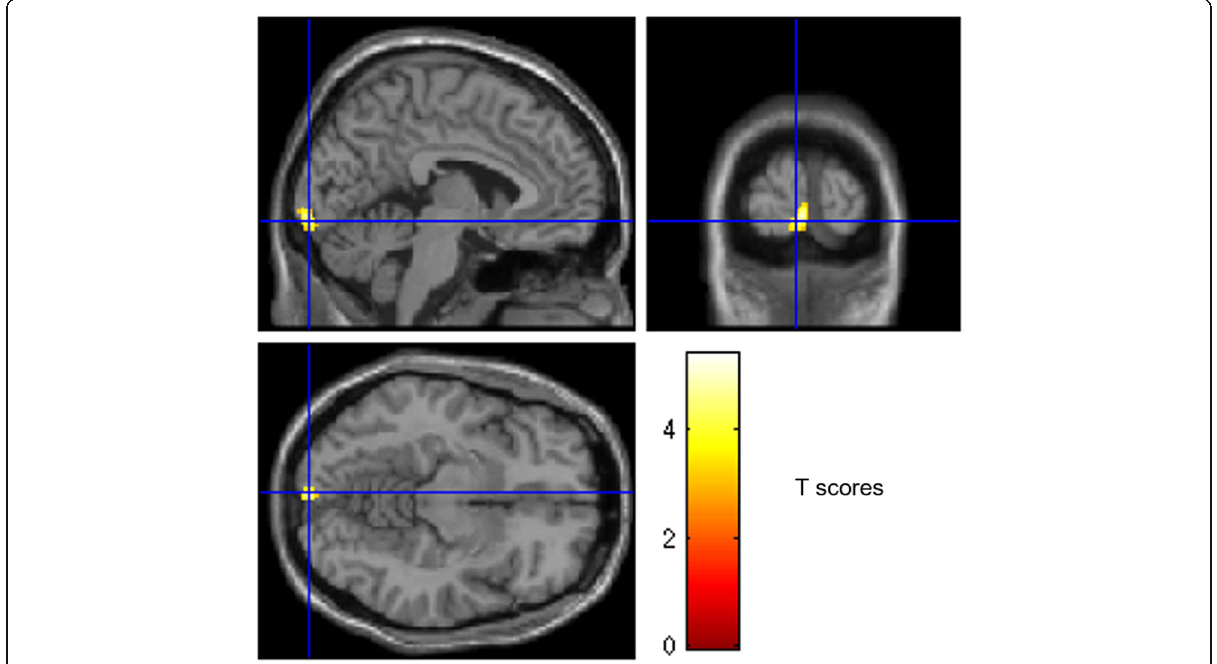
Fig. 2 Anatomical localization of areas of increased metabolism in patients with acrophobia in relation to increased BAT score before treatment, projected onto sections of a standard SPM8 MRI template. Before treatment, a positive correlation was found between the BAT score and metabolism of the left occipital areas (BA17-18) ( p < 0.005, k > 90). L : left, R :